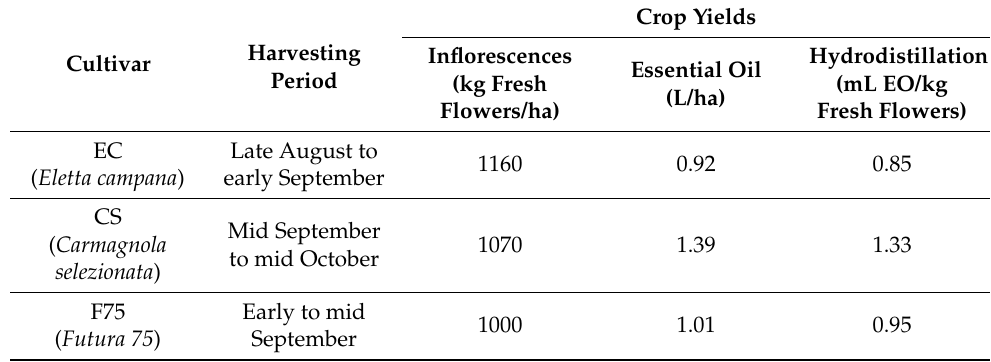
Table 2. Agronomical performances of the tested hemp cultivars.